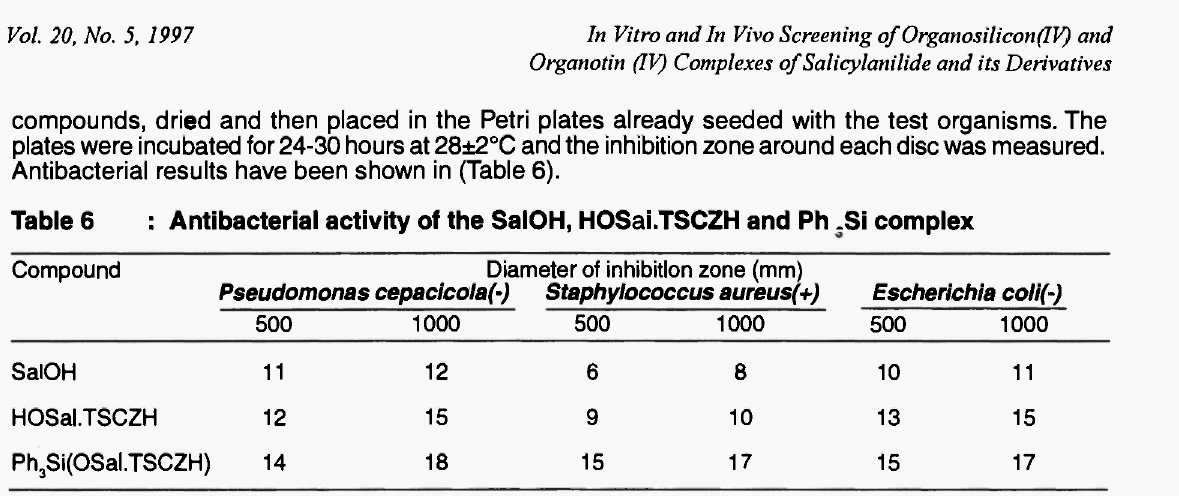
Table 7 : Changes in the body weight and organs weight of reproductive organs after treatment with